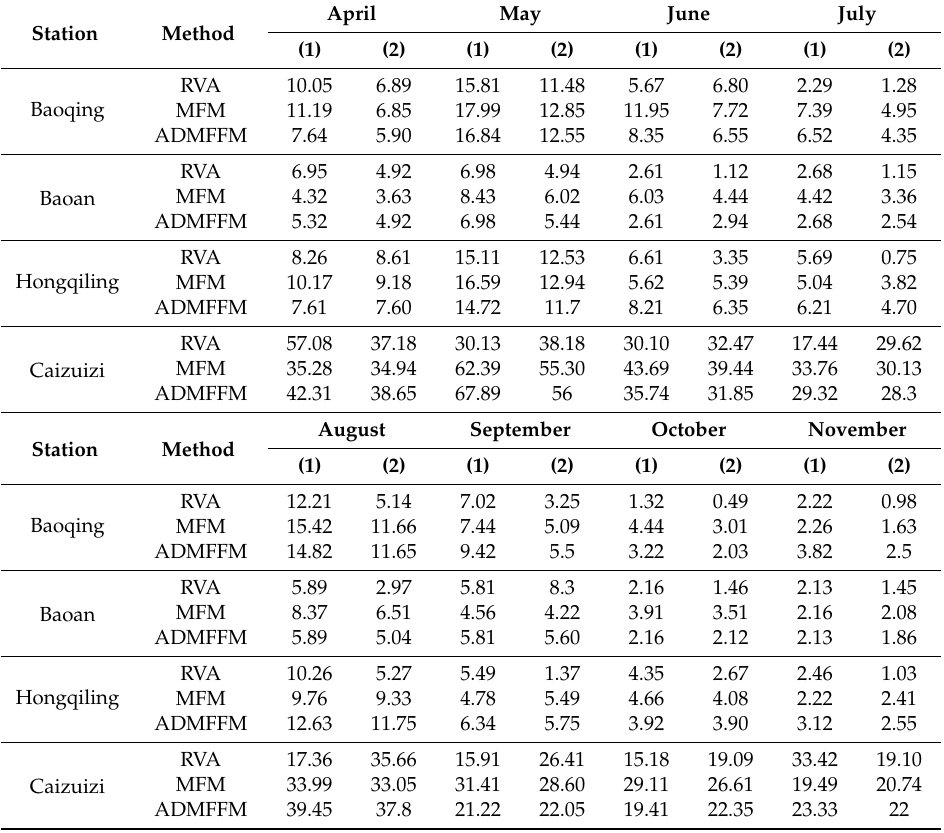
Table 2. Ecological flow of the selected series and the whole series in the four stations in the Naolihe basin (m 3 /s).